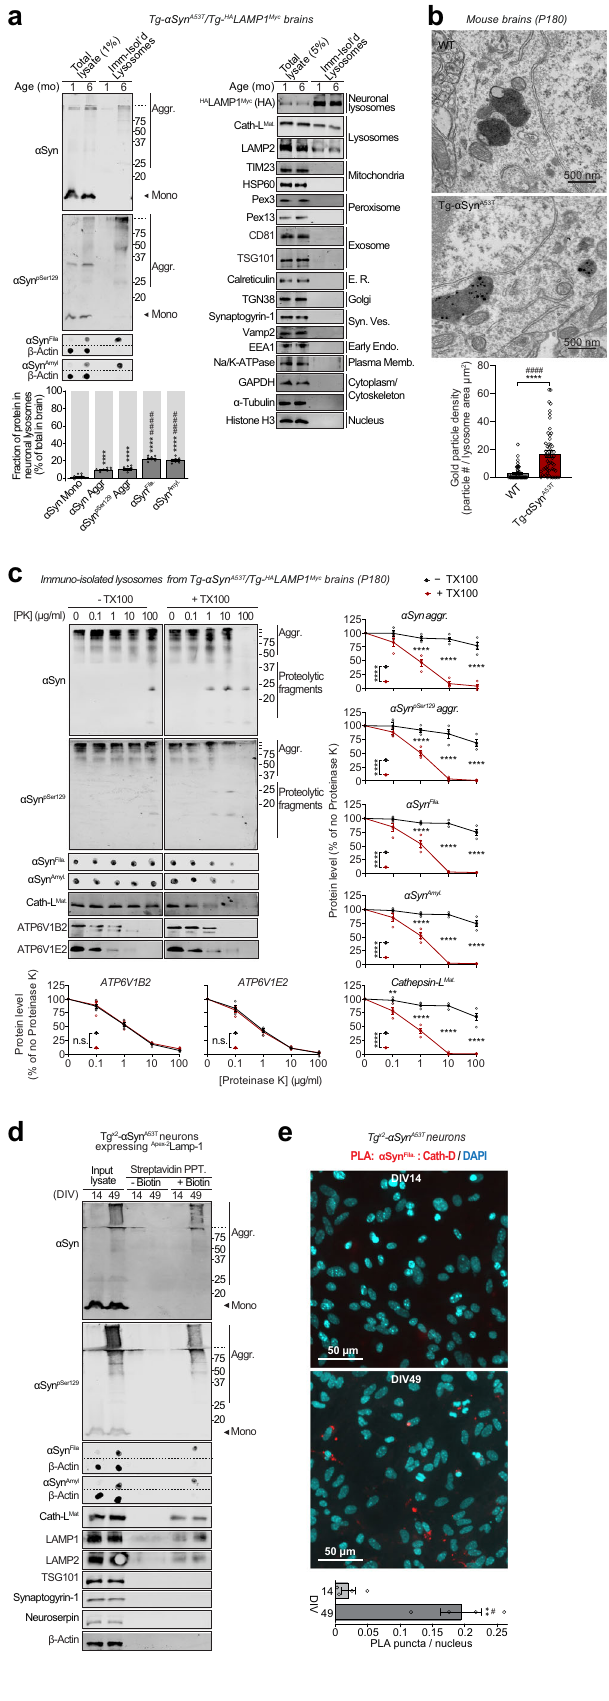
Pathogenic α Syn species are secreted from neurons via SNARE- dependent lysosomal exocytosis Release of α Syn from neurons, particularly the seeding-competent pathogenic versions of α Syn, is considered a key step in the spatial progression of synucleinopathies 38 , and α Syn has been documented in extracellular fl uids of PD patients 6 . We also found pathogenic species of α Syn in the cerebrospinal fl uid of aged Tg- α Syn A53T mice (Fig. 4a). Importantly, this extracellular pool of α Syn aggregates is not envel- oped in membranes, as they were not protected from proteinase K digestion (Fig. 4a), and their proteolytic susceptibility was unaffected by the presence of detergent, akin to the lysosomal luminal protein cathepsin-L and neuroserpin — a non-lysosomal secreted protein (Fig. 4a). This was contrary to the well-protected contents of exo- somes, typi fi ed by TSG101, which becomes susceptible to proteolysis only in the presence of detergent (Fig. 4a).